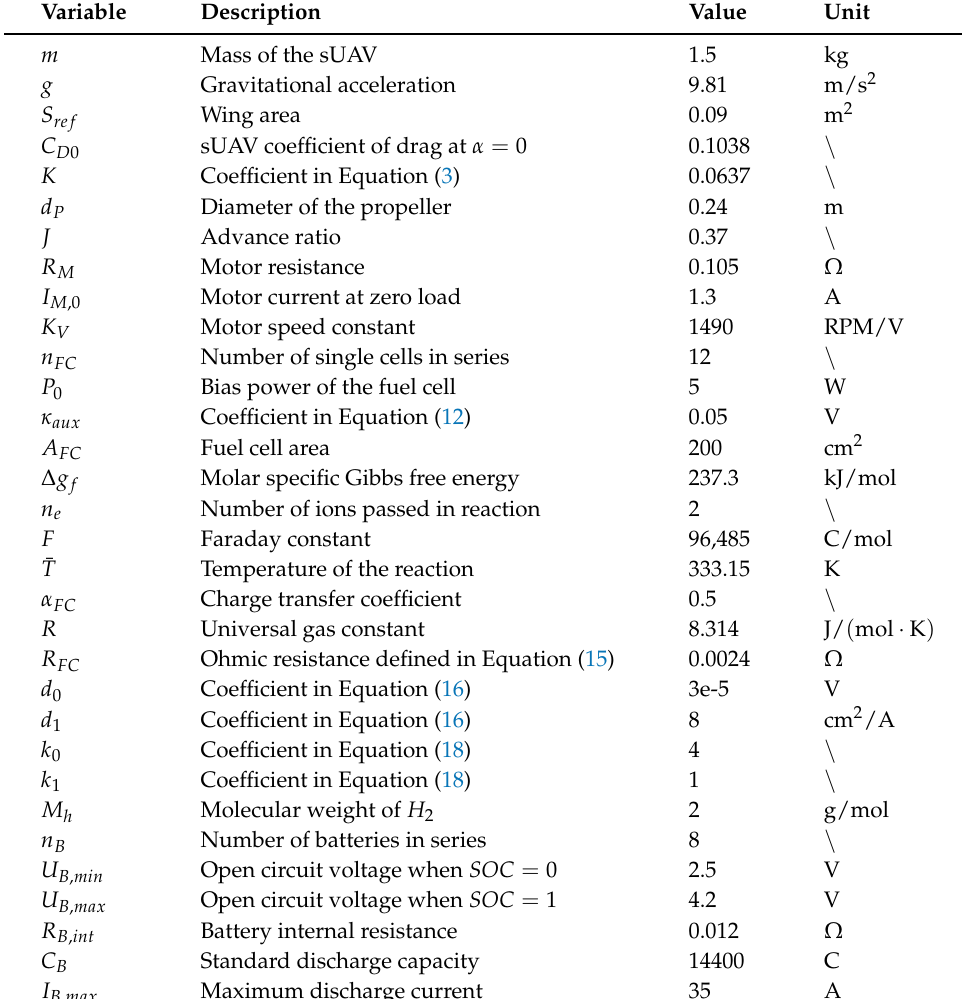
The parameters of the sUAV model described in the paper are listed in Table A1. Table A1. Parameters used in the sUAV